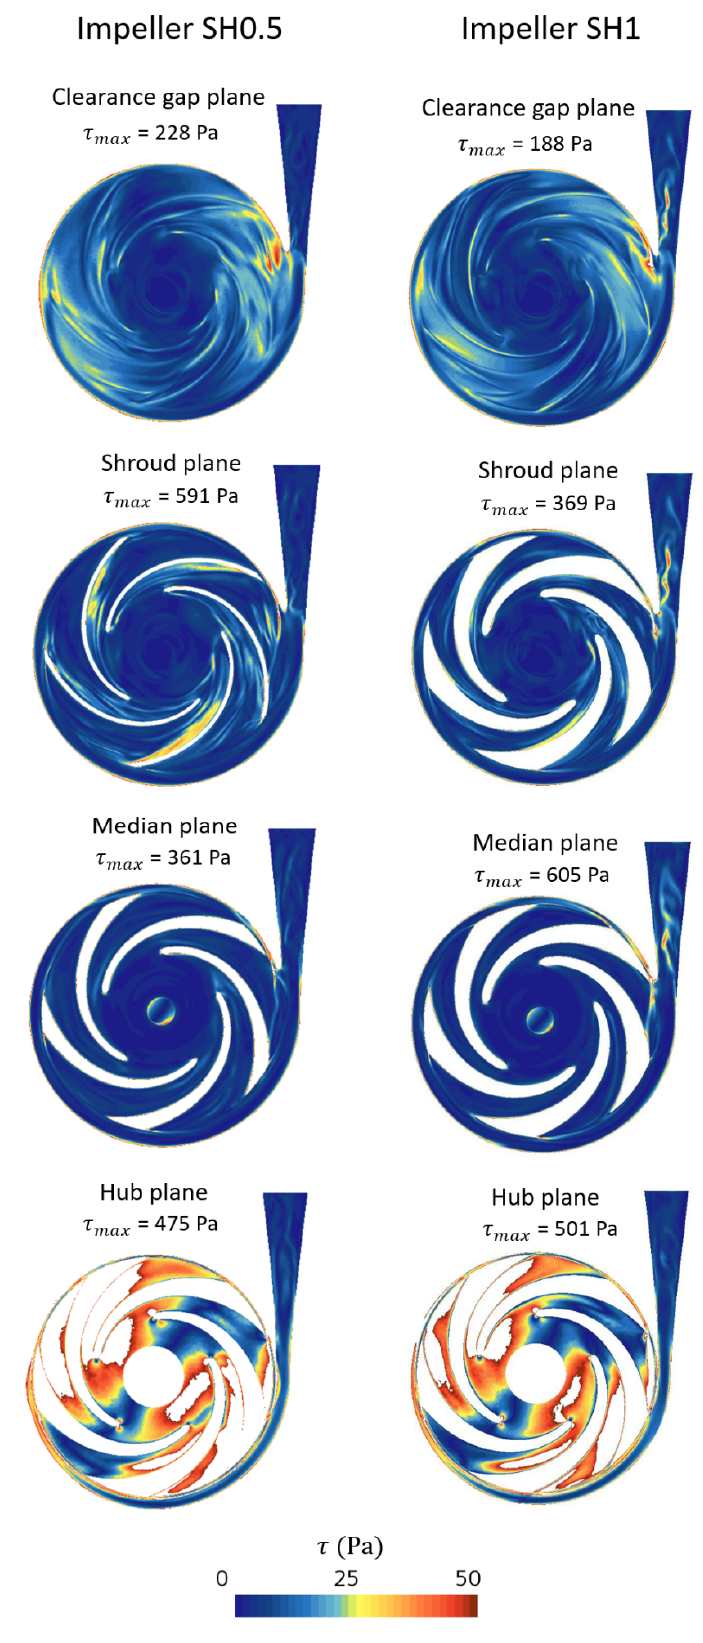
Figure 10. SSS fi elds of the two pumps at four planes. Figure 10. SSS fields of the two pumps at four